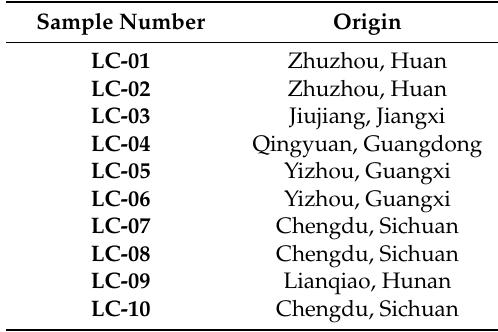
Table 1. Ten batches of Lobelia chinensis samples collected from different areas of